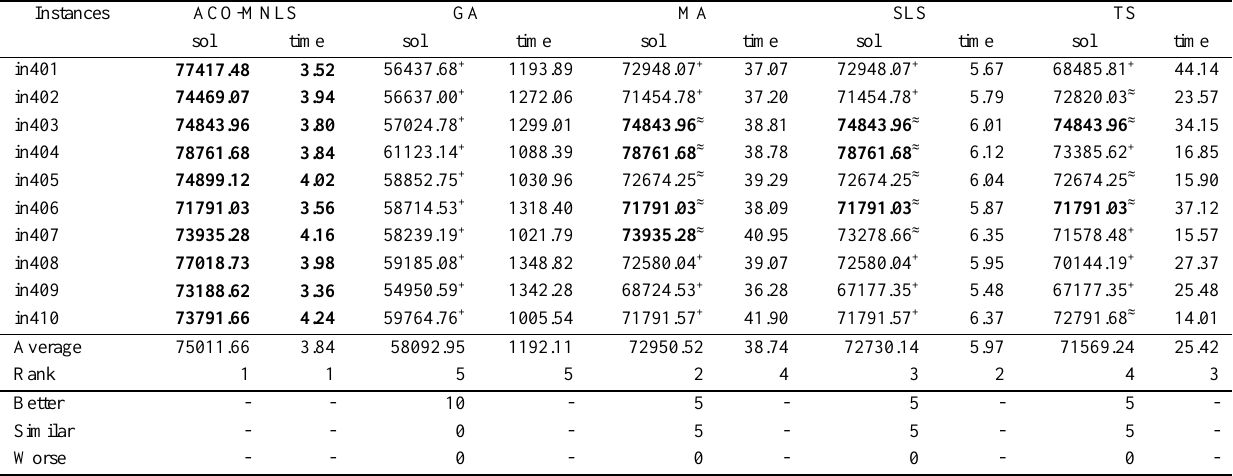
Table 4. Experimental results of proposed ACO-MNLS, GA, MA, SLS, and TS on some instances of